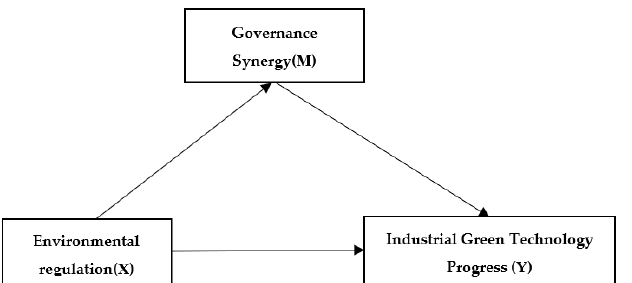
Figure 1. The mediating effect mechanism of environmental regulation, governance synergy, and industrial green technology progress.